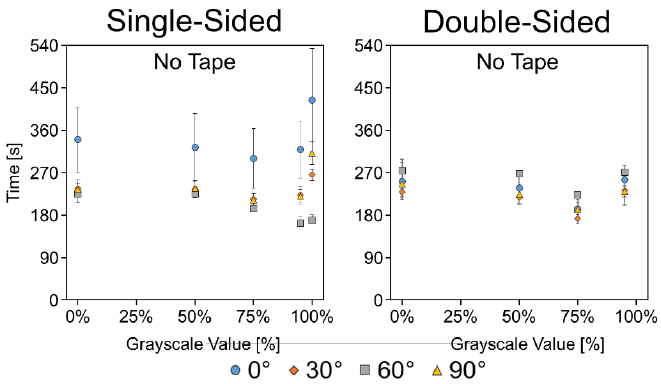
Figure 7. Angled wicking data for single- and double-sided etched channels without tape. Data